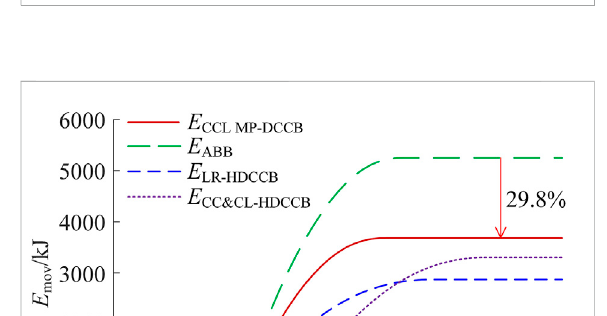
FIGURE 12 Voltage comparison across DC circuit breakers.